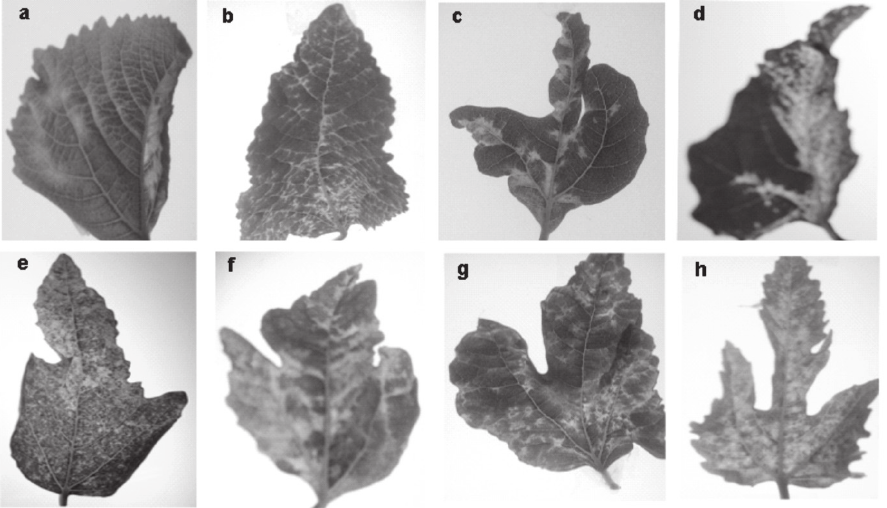
Figure 1. Symptoms of fi g-mosaic diseased plants observed in inspected fi g orchards and showing a wide range of fo- liar discoloration and malformation symptoms. (a) vein feathering, (b) vein banding, (c) leaf deformation, (d) chlorosis, (e) mosaic, (f) chlorotic blotching, (g) chlorotic ringspot and (h) leaf